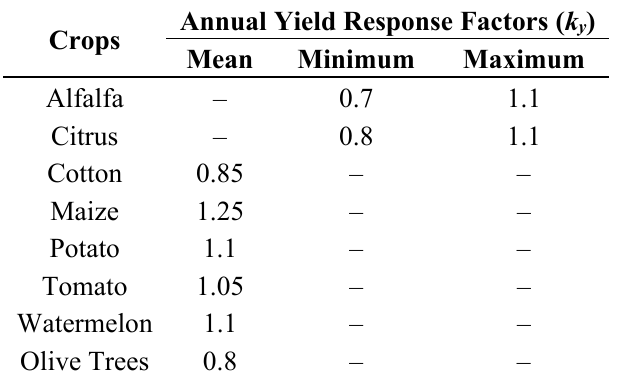
Table 8. Annual yield response factors ( k y ) based on [42].